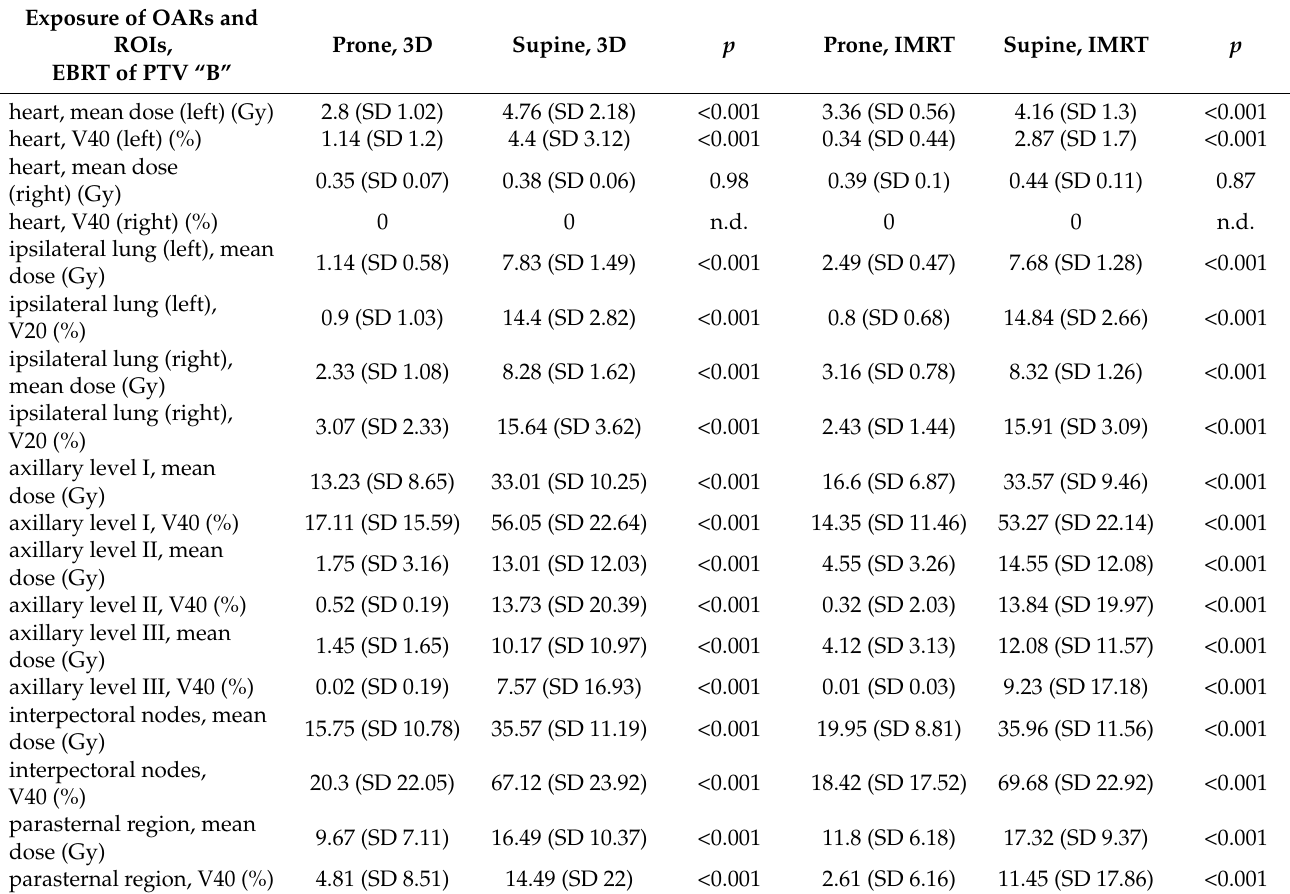
Table 1. Exposure of the OARs and ROIs, subdivided according to positioning and planning technique in Gy (mean dose) or percent (V20/V40). Here, only the EBRT of PTV “B” was considered. Exposure of the heart was only calculated for left-sided cancer patients. SD: standard deviation, n.d.: not